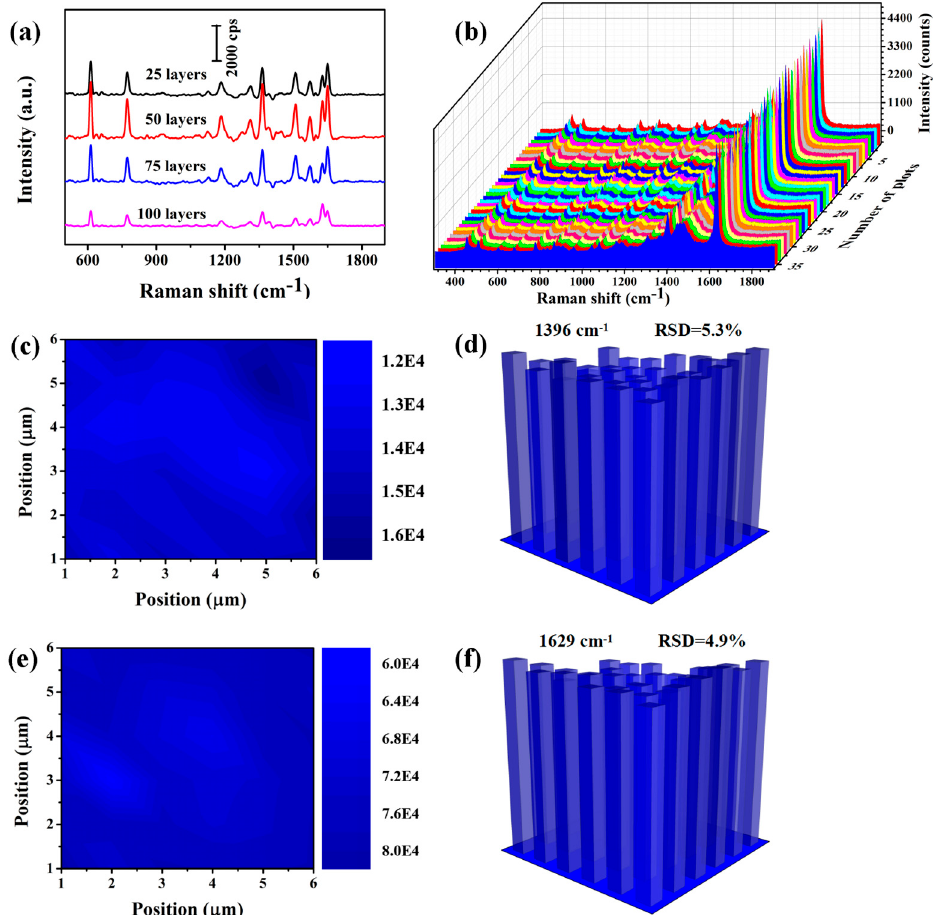
Figure 11. ( a ) Raman spectra of R6G molecules with 10 − 3 M concentration from the different layers film substrates. ( b ) SERS spectra of MB obtained on 36 random locations from 6 different MXene-SO3H/MB-50 film substrates. ( c , e ) Raman mapping image at 1396 and 1629 cm − 1 of MB molecules with cover the area of 6 × 6 µ m 2 of the MXene-SO3H/MB-50 film substrate. ( d , f ) The corresponding bar plot of Raman intensity at 1396 and 1629 cm − 1 in the above detection area of MXene-SO3H/MB-50 film substrate.